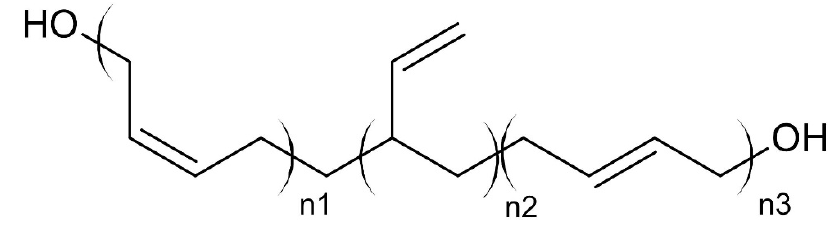
Figure 1. Chemical structure of hydroxyl terminated polybutadiene (HTPB).